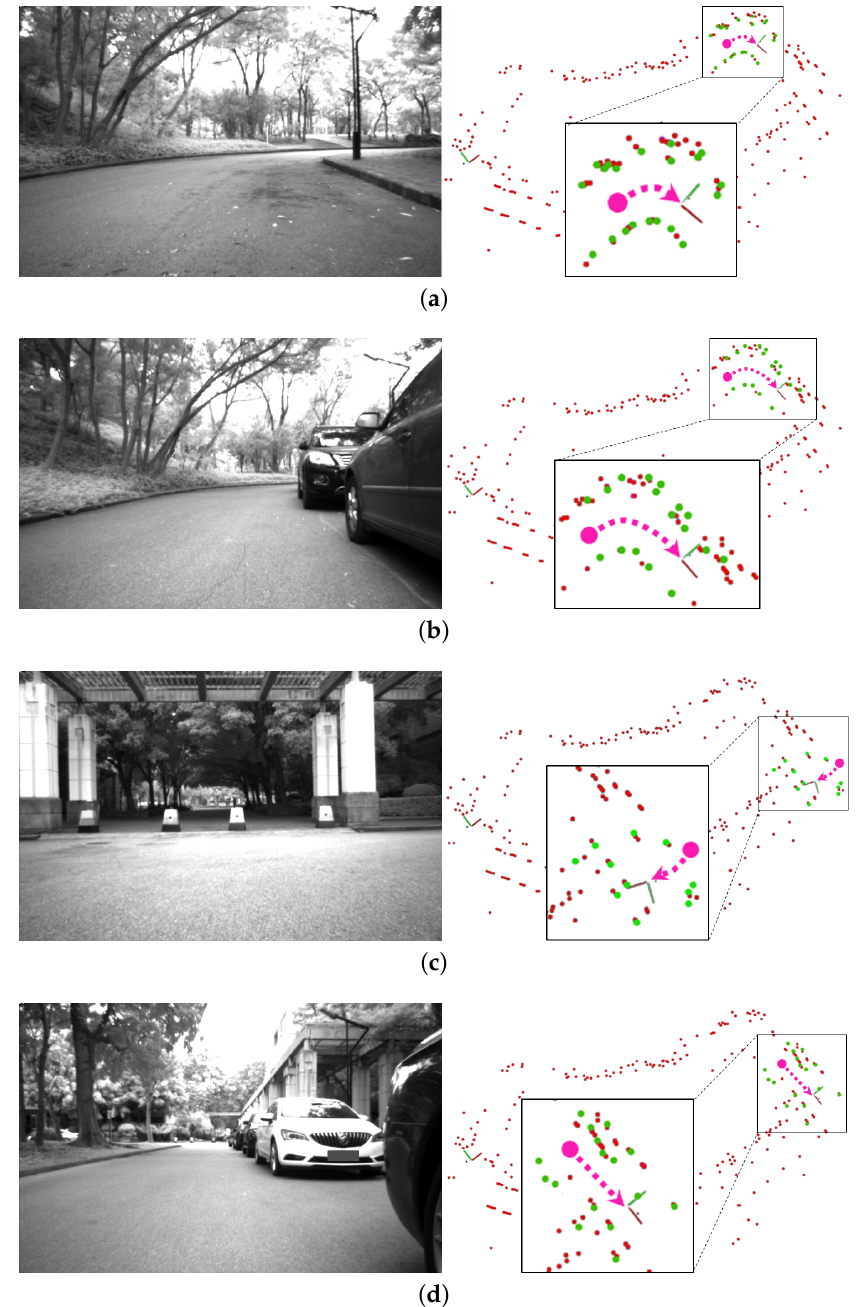
Figure 11. Experiments of relocalization in our campus. ( a , b ) The results at the same location but at different times with a three-month interval; ( c , d ) the results at the same location but from different entry